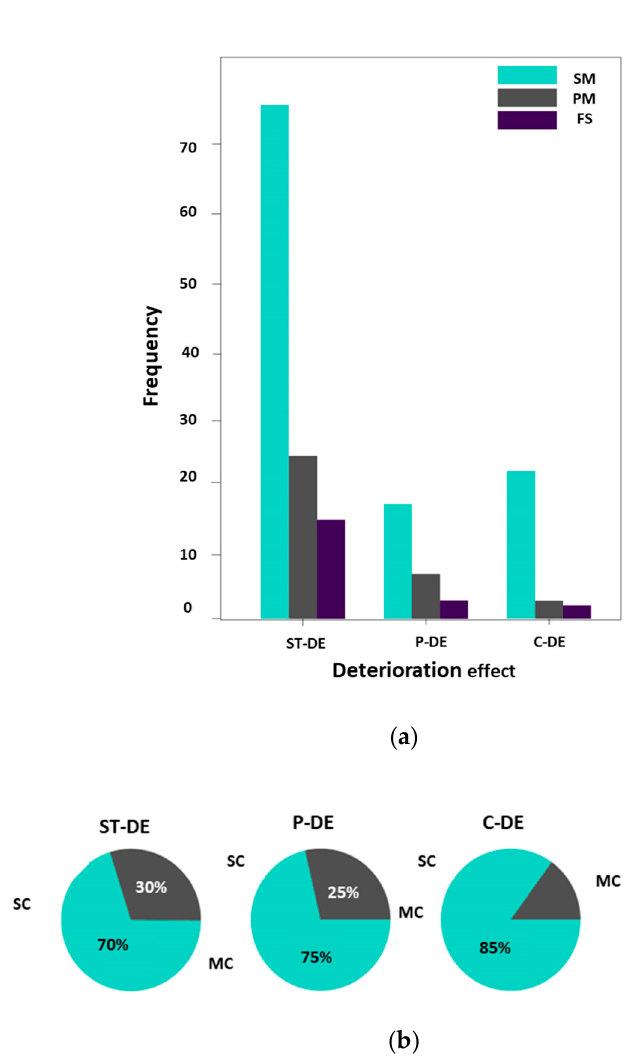
Figure 9. ( a ) System configuration vs. deterioration effect approach. ( b ) Deterioration effect approach vs. objective function types.